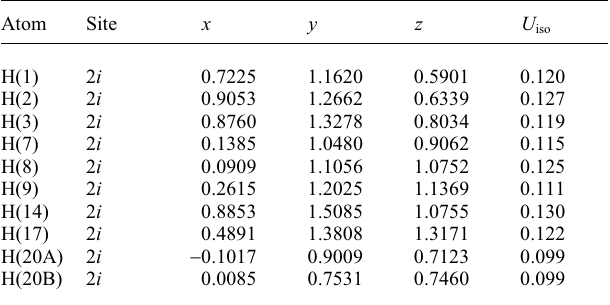
Table 2. Atomic coordinates and displacement parameters (in Å 2 )